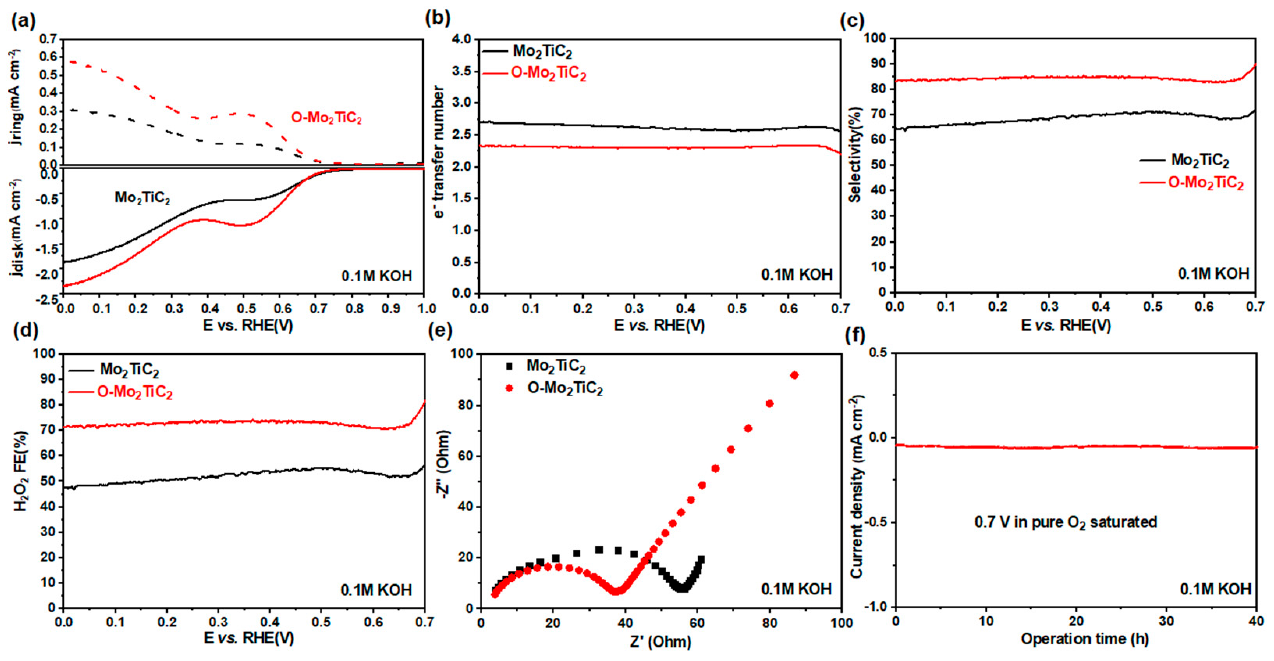
Figure 5. ( a ) Polarization curves (solid line) and H 2 O 2 detection current densities (dashed lines) at the ring electrode for Mo 2 TiC 2 MXene and O-Mo 2 TiC 2 t at 1600 rpm in 0.1 M KOH solution. ( b − d ) Transfer electron number, H 2 O 2 selectivity, and Faradaic efficiency of Mo 2 TiC 2 MXene and O-Mo 2 TiC 2 in 0.1 M KOH solution. ( e ) Nyquist plots of catalysts O-Mo 2 TiC 2 and Mo 2 TiC 2 MXene in 0.1 M KOH solution. ( f ) Stability test of catalyst O-Mo 2 TiC 2 in 0.1 M KOH solution for 40 h.